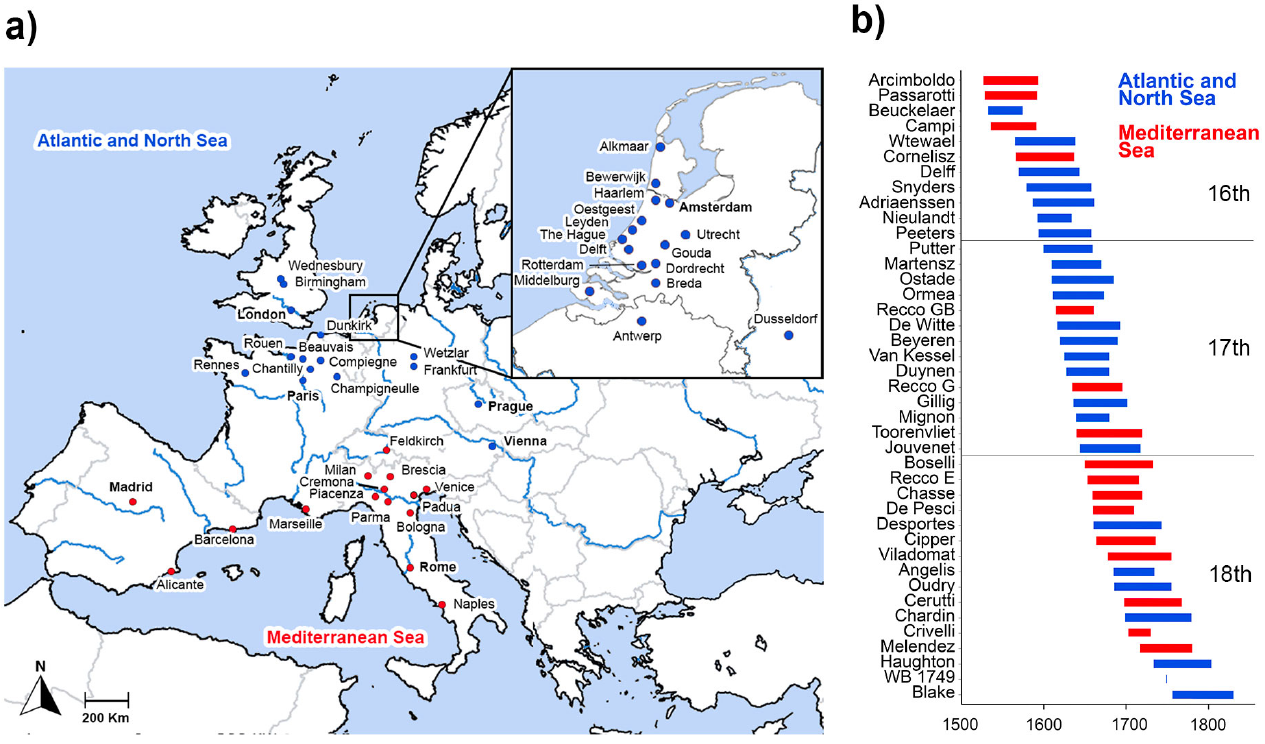
Fig. 2 . Locations and dates of birth and death of the artists included in the study. (a) Location of the cities of birth and death, and of the main activity of the artists included in the study with delineation of their zonal belonging. (b) Dates of birth and death of the artists, colored according to their region of